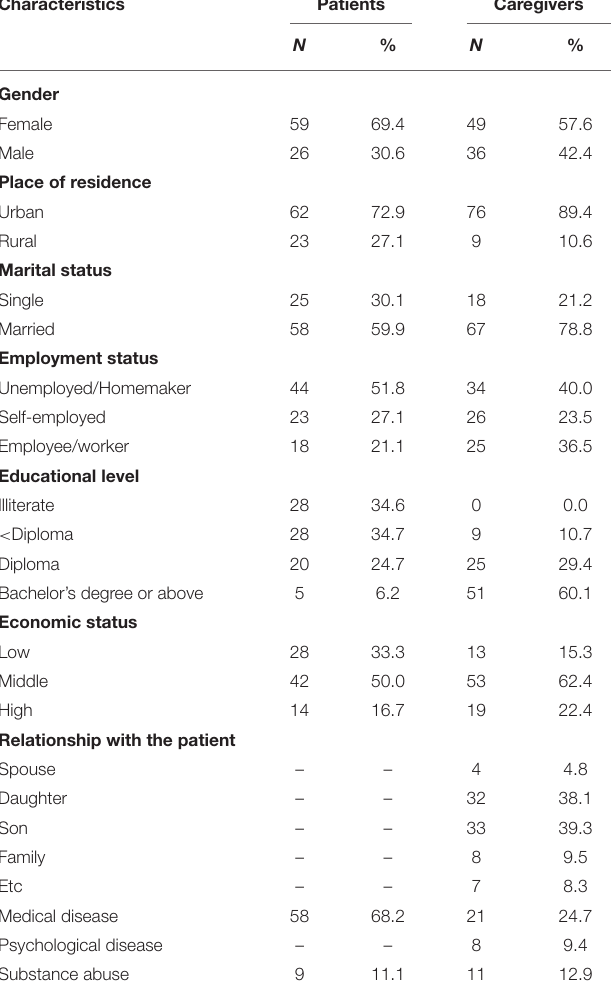
TABLE 1 | Demographic and clinical characteristics of